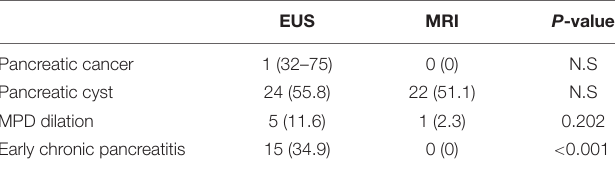
TABLE 4 | Pancreatic findings according to